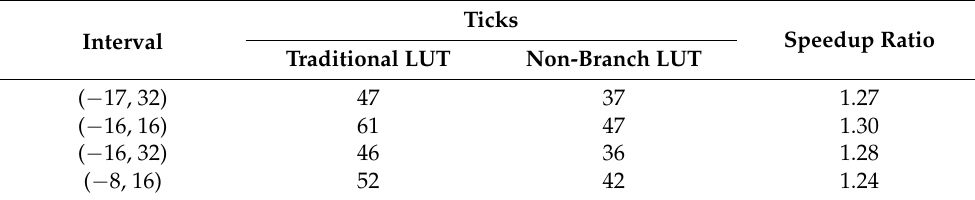
Table 2. Performance comparison of non-branch and traditional LUT for ELU